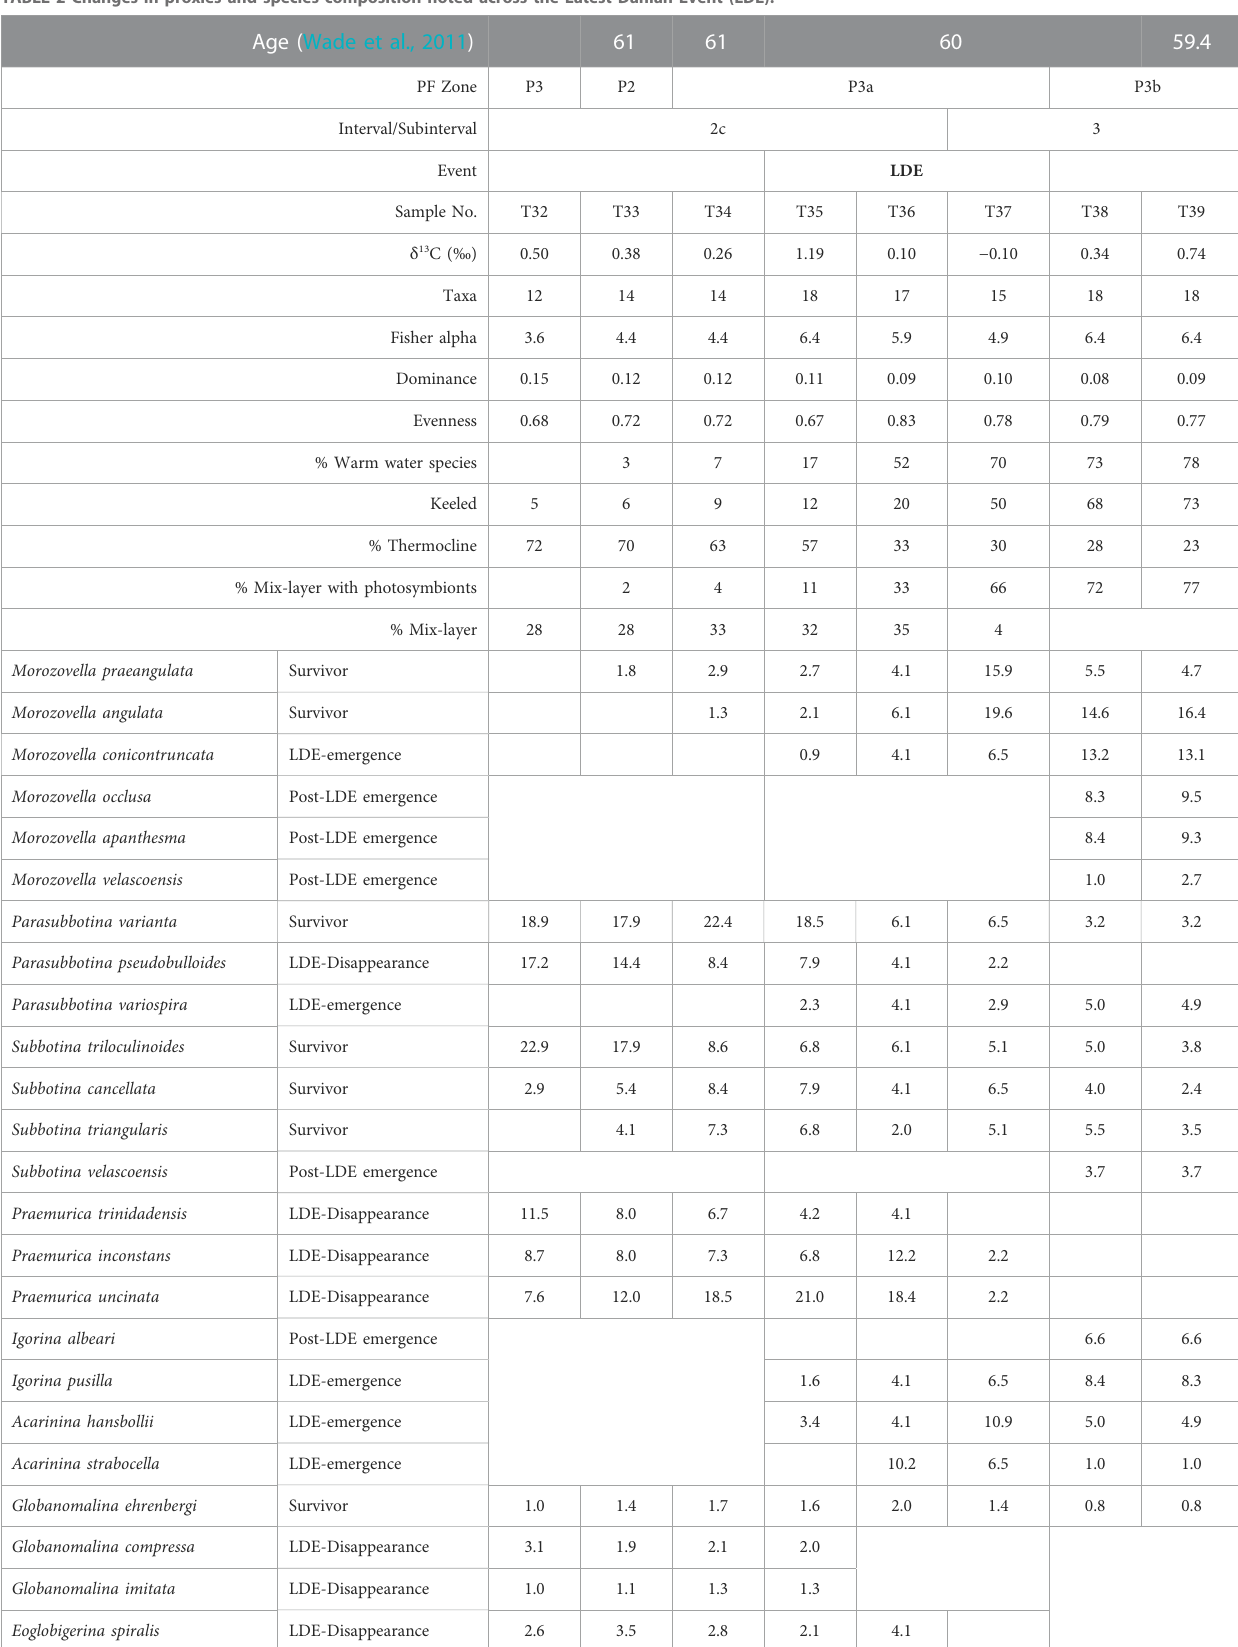
TABLE 2 Changes in proxies and species composition noted across the Latest Danian Event (LDE). Age (Wade et al.,